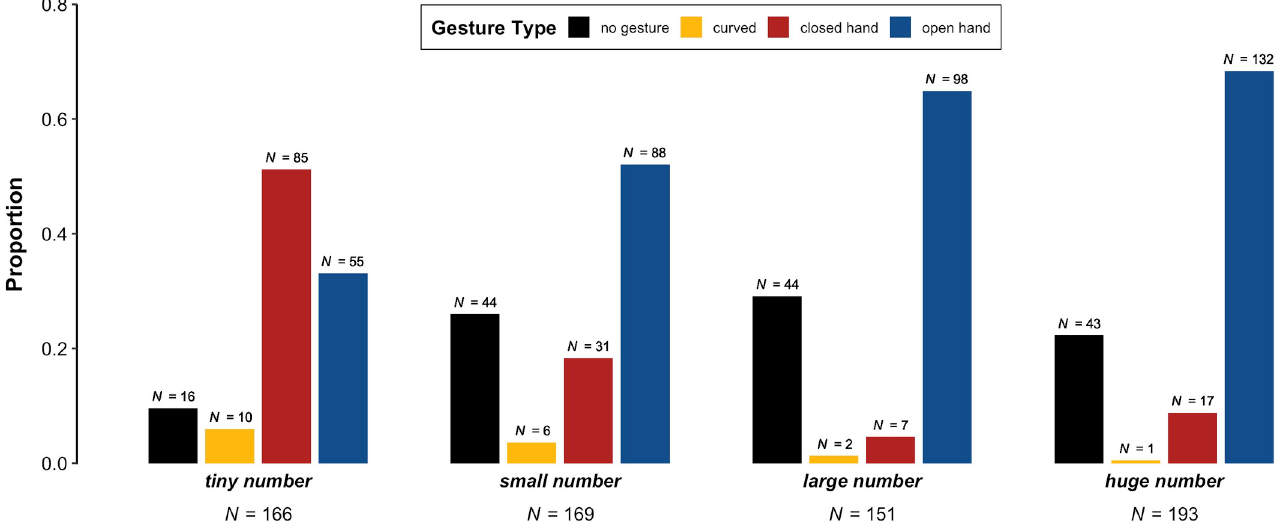
PLOS ONE | https://doi.org/10.1371/journal.pone.0242142 November17,